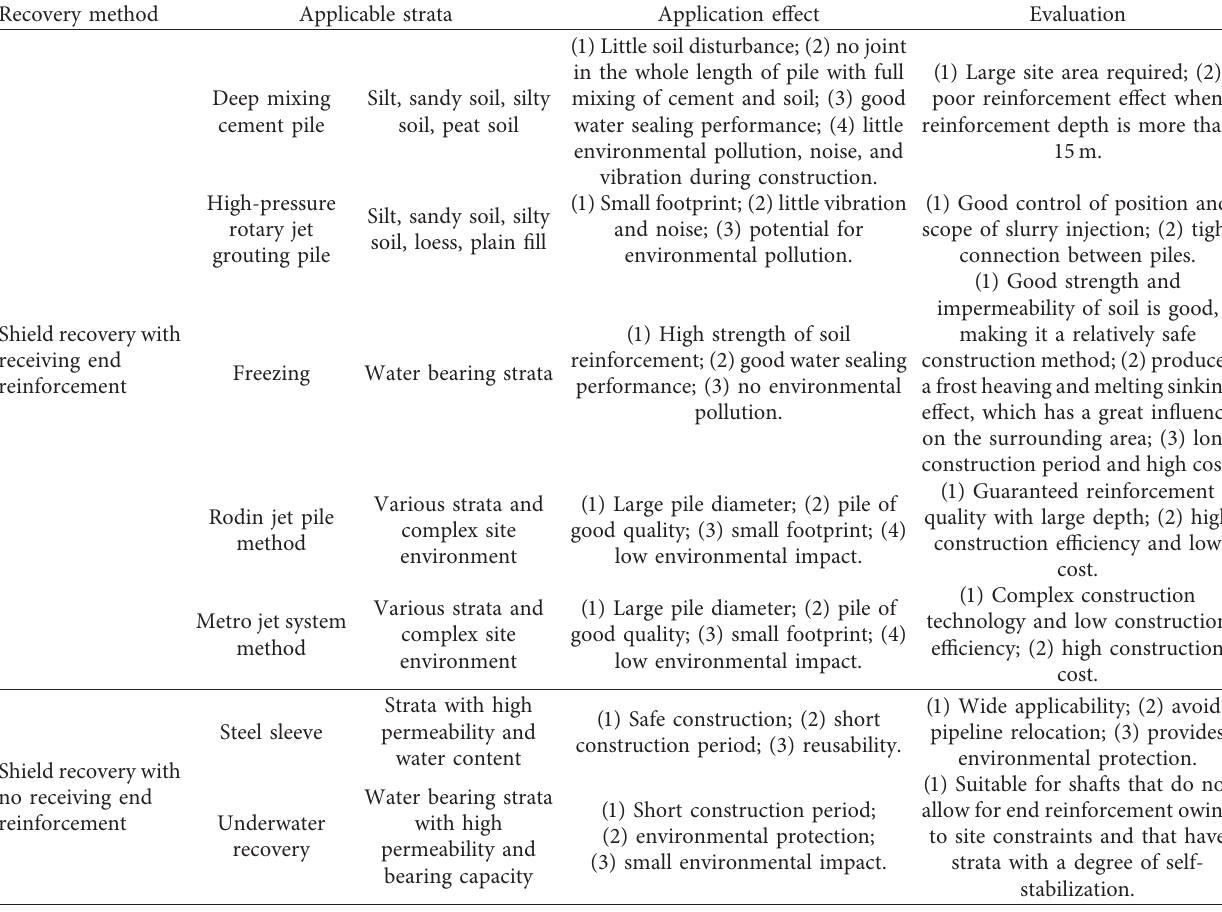
Table 4: Comparison of different methods of shield